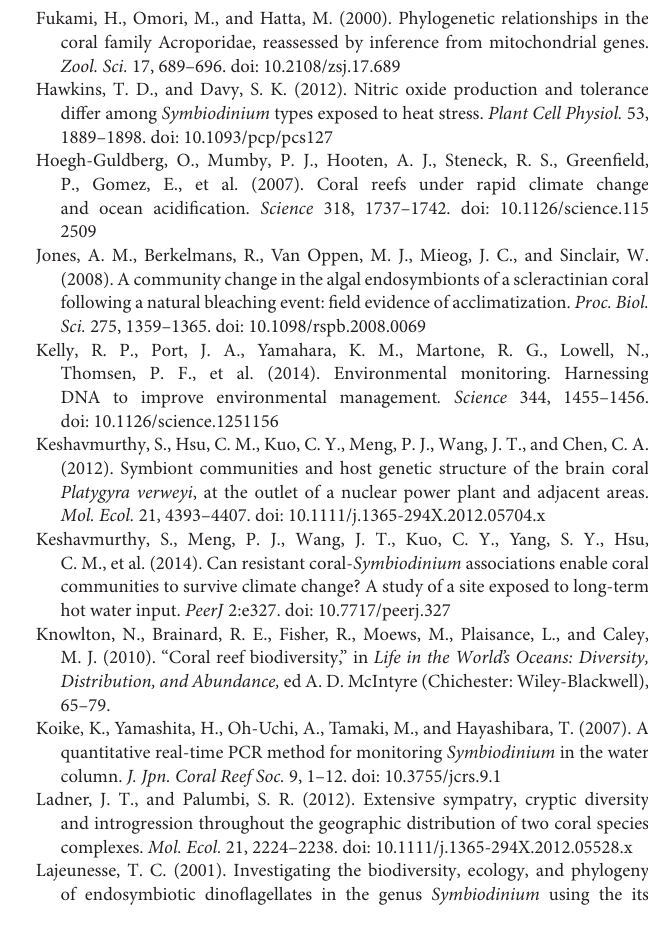
Table S5 | Weight in water and number of valid alignments of Acropora species used in this